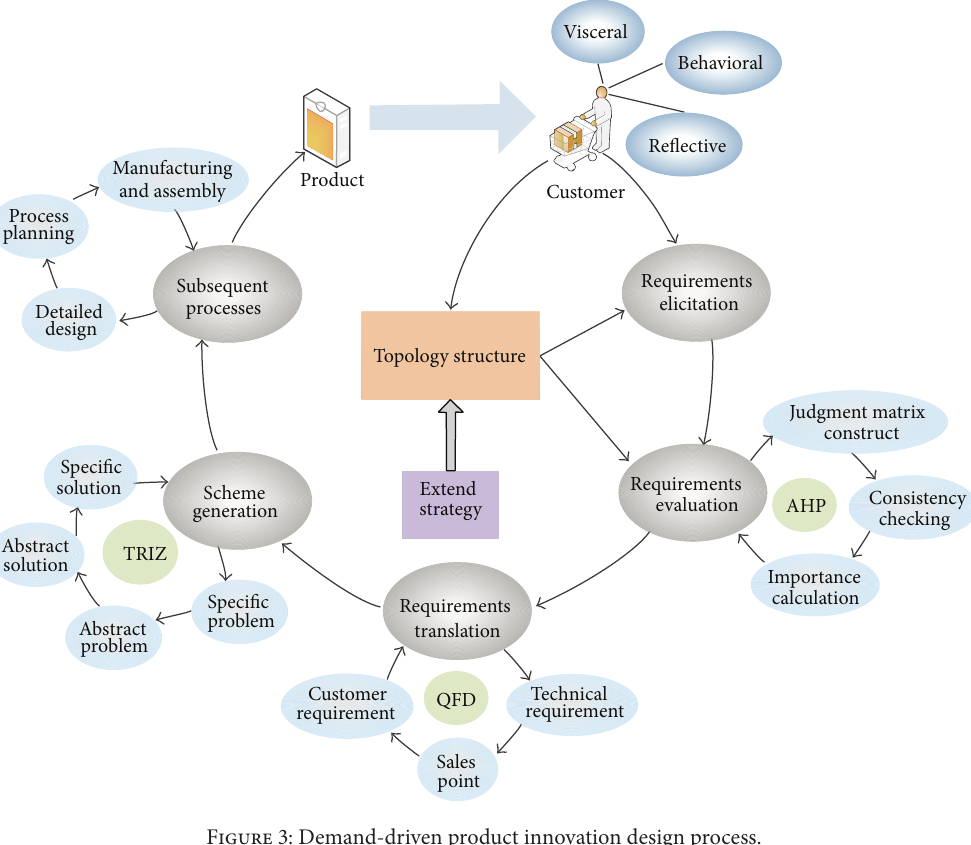
Figure 3: Demand-driven product innovation design process.